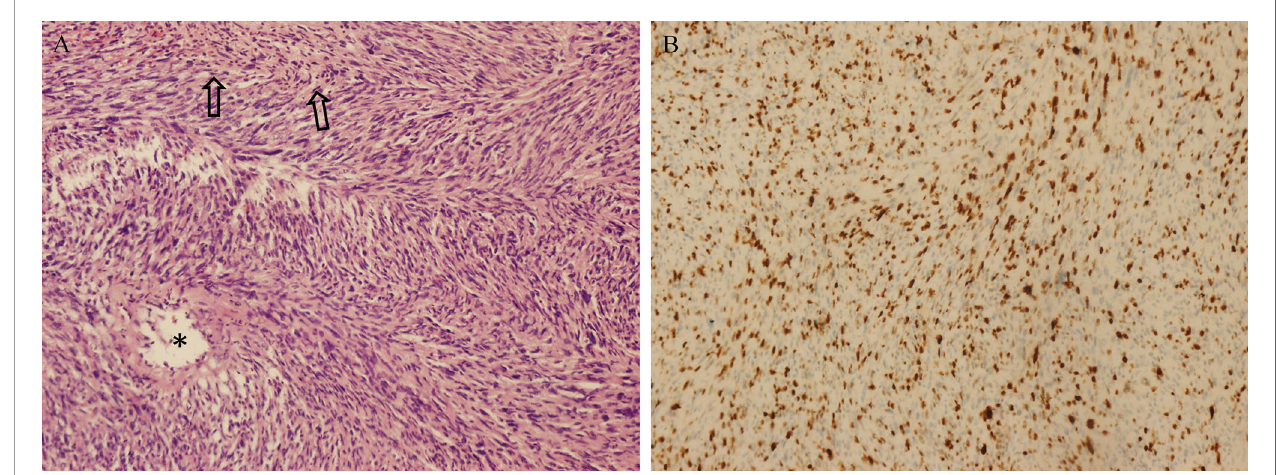
FIGURE 4 | Pathological fi ndings of MTVSs. Photomicrographs obtained during pathological examination of tumor tissue of Case 1. An H & E – stained section (A) showing the differentiation of MPNST with gland formation (asterisks) and necrosis (arrows) . Immunohistochemical staining for Ki-67 (B) was positive with 30%, revealing the diagnosis of MPNST (WHO grade 3/FCNLCC Grade 2). Original magni fi cation ×200 (A, B)